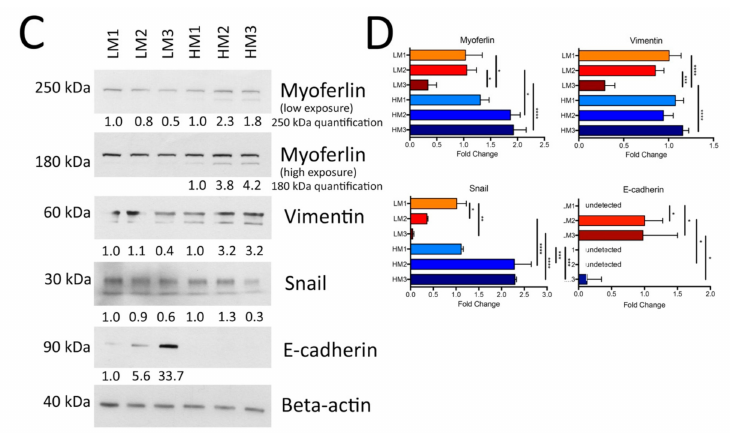
Figure 4. Myoferlin is overexpressed in cells with a high metastatic potential. ( A ) Schematic representation of the in vivo selection of liver-tropic PDAC cells used to generate low metastatic (LM) and highly metastatic (HM) clones. Adapted from [34]. ( B ) Representative liver from mice injected with the liver-tropic Panc-1 cells selected after one, two, or three rounds of injection. ( C ) Western-blot evaluation of myoferlin, vimentin, snail, and E-cadherin abundance in Panc-1 clones selected for their low (LM) or high (HM) metastatic potential. Beta-actin was used as a loading control. ( D ) Gene expression (mRNA) level for myoferlin, vimentin, snail, and E-cadherin in Panc-1 clones selected for their low (LM) or high (HM) metastatic potential. LM1 (LM2 for E-cadherin) gene expression was fixed to 1 and other samples were compared to LM1 (LM2 for E-cadherin). One representative experiment out of three is illustrated. Each data point represents mean ± SD, n = 3. **** P < 0.0001, *** P < 0.001, ** P < 0.01, * P <